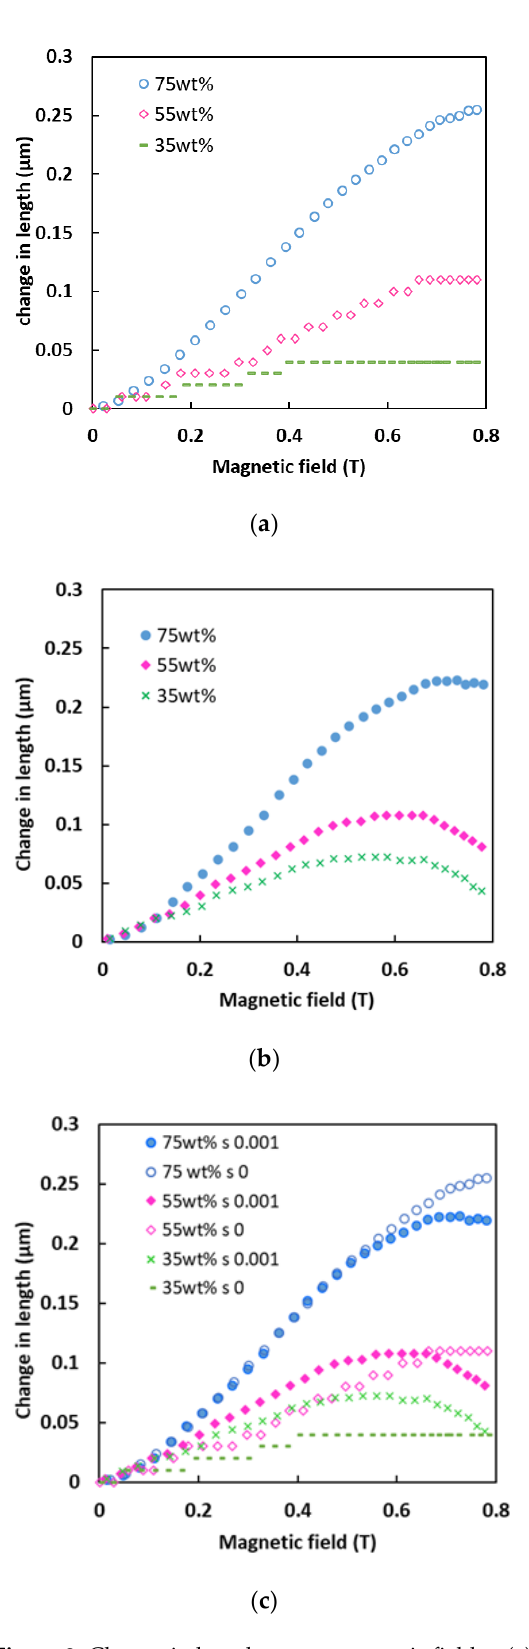
Figure 2. Change in length versus magnetic field at ( a ) zero, ( b ) 0.001% of shear strain, and ( c ) comparison between zero and 0.001% of shear strain.